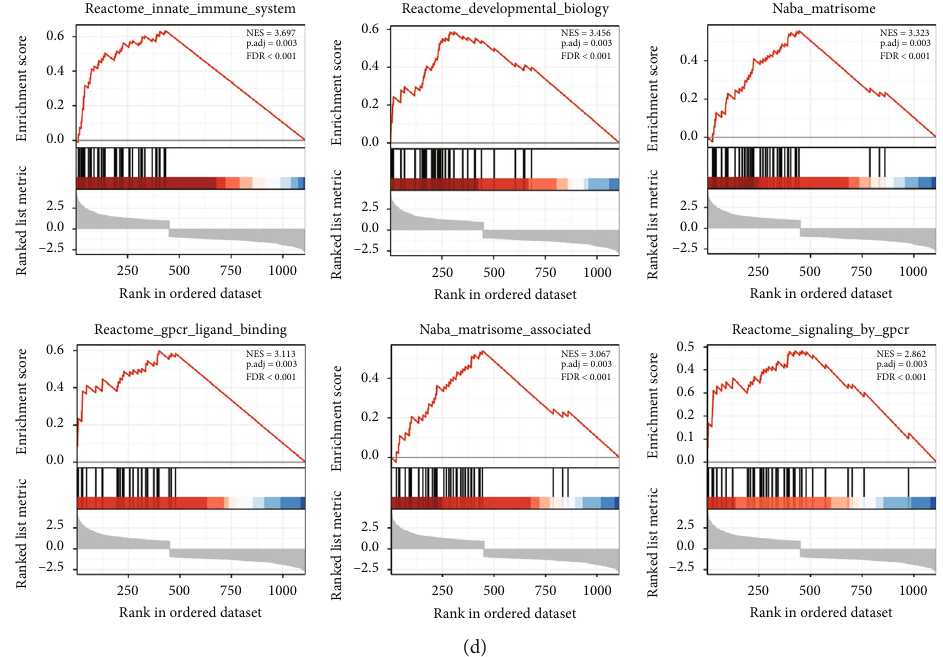
Figure 6: Enrichment analysis of DEGs in TCGA-LUAD cohort (n=447). (a) Volcano plot depicting DEGs in the high- and low-risk groups in the training cohort (including 566 upregulated and 1350 downregulated genes). (b) GO analysis was used to determine critical biological processes, cellular components and molecular functions, indicating that the DEGs were signi fi cantly enriched in immune- related processes. (c) Chord diagram demonstrating the results of KEGG analysis, indicating that the DEGs were considerably enriched in immune-related signalling pathways. (d) GSEA of the high- and low-risk groups based on the CTCR